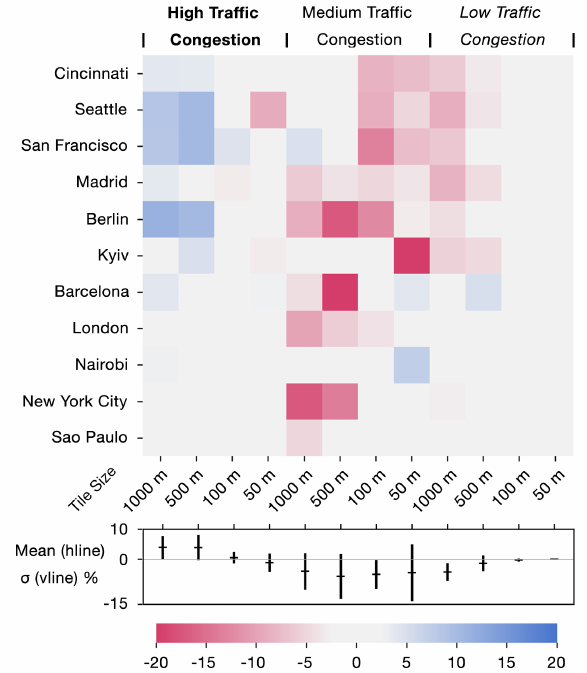
Figure 5. The plot compares the performance of two Twitter aggregation methods per tile: (i) User count on a road segment and (ii) User count on a road segment + User count within a vicinity . The colour indicates the difference in the percentage of correctly classified tiles between the predictions based on the two approaches. A positive value (blue) implies that the aggregation method using the combination of the two proxies is a better